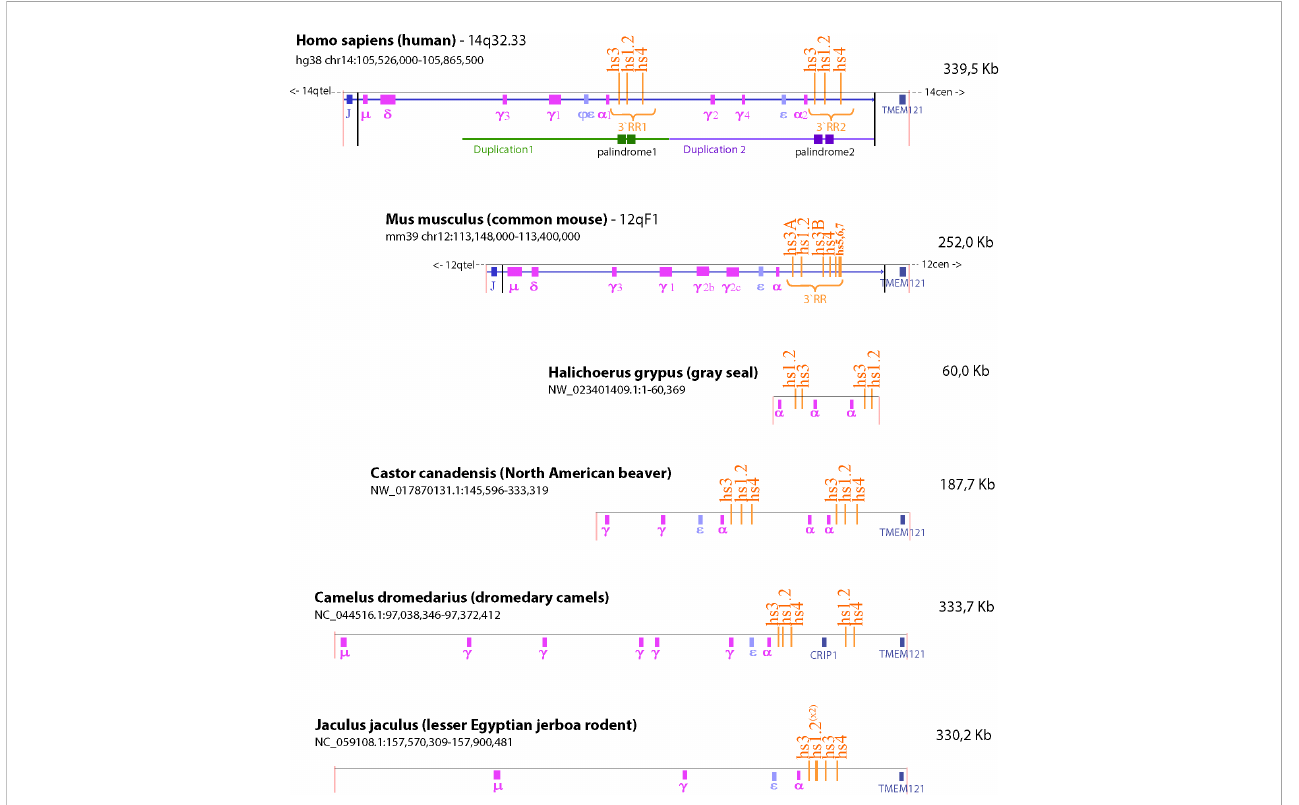
FIGURE 4 Species comparison of the IgH gene locus. The schematic illustrates the similarities and differences in the number of IgH constant regions and composition of the 3 ’ RR among six different species (i.e. human, mouse, gray seal, North American beaver, dromedary camel, and lesser Egyptian jerboa rodent). The NCBI refseq number and location of the sequence depicted are identi fi ed under the species name. TMEM121 was used as a reference of synteny because it is the gene closest to the IgH region. Duplication of or within the 3 ’ RR occurred in both human and mouse. However, the murine 3 ’ RR has an internal duplication that produces two copies of the hs3 enhancer (hs3A and hs3B); whereas the human genome contains two 3 ’ RRs (i.e. 3 ’ RR1 and 3 ’ RR2) due to a large duplication of constant region genes and the hs3, hs1.2 and hs4 enhancers. Analysis of species quite far in phylogenesis identi fi ed the presence of distinct and varied duplications in the IgH gene that include duplications of constant regions and the 3 ’ RR enhancers. This wide range of arrangements within the IgH gene among different species suggests that many of these duplications happened independently in various branches of the evolutionary